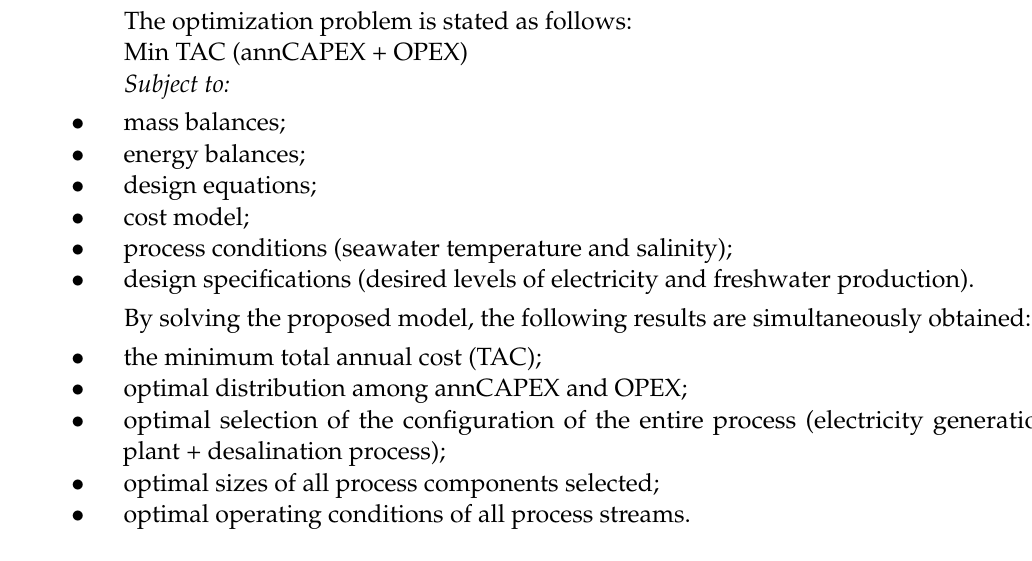
Figure 4. The superstructure of the dual-purpose power and desalination plant (DPPDP).